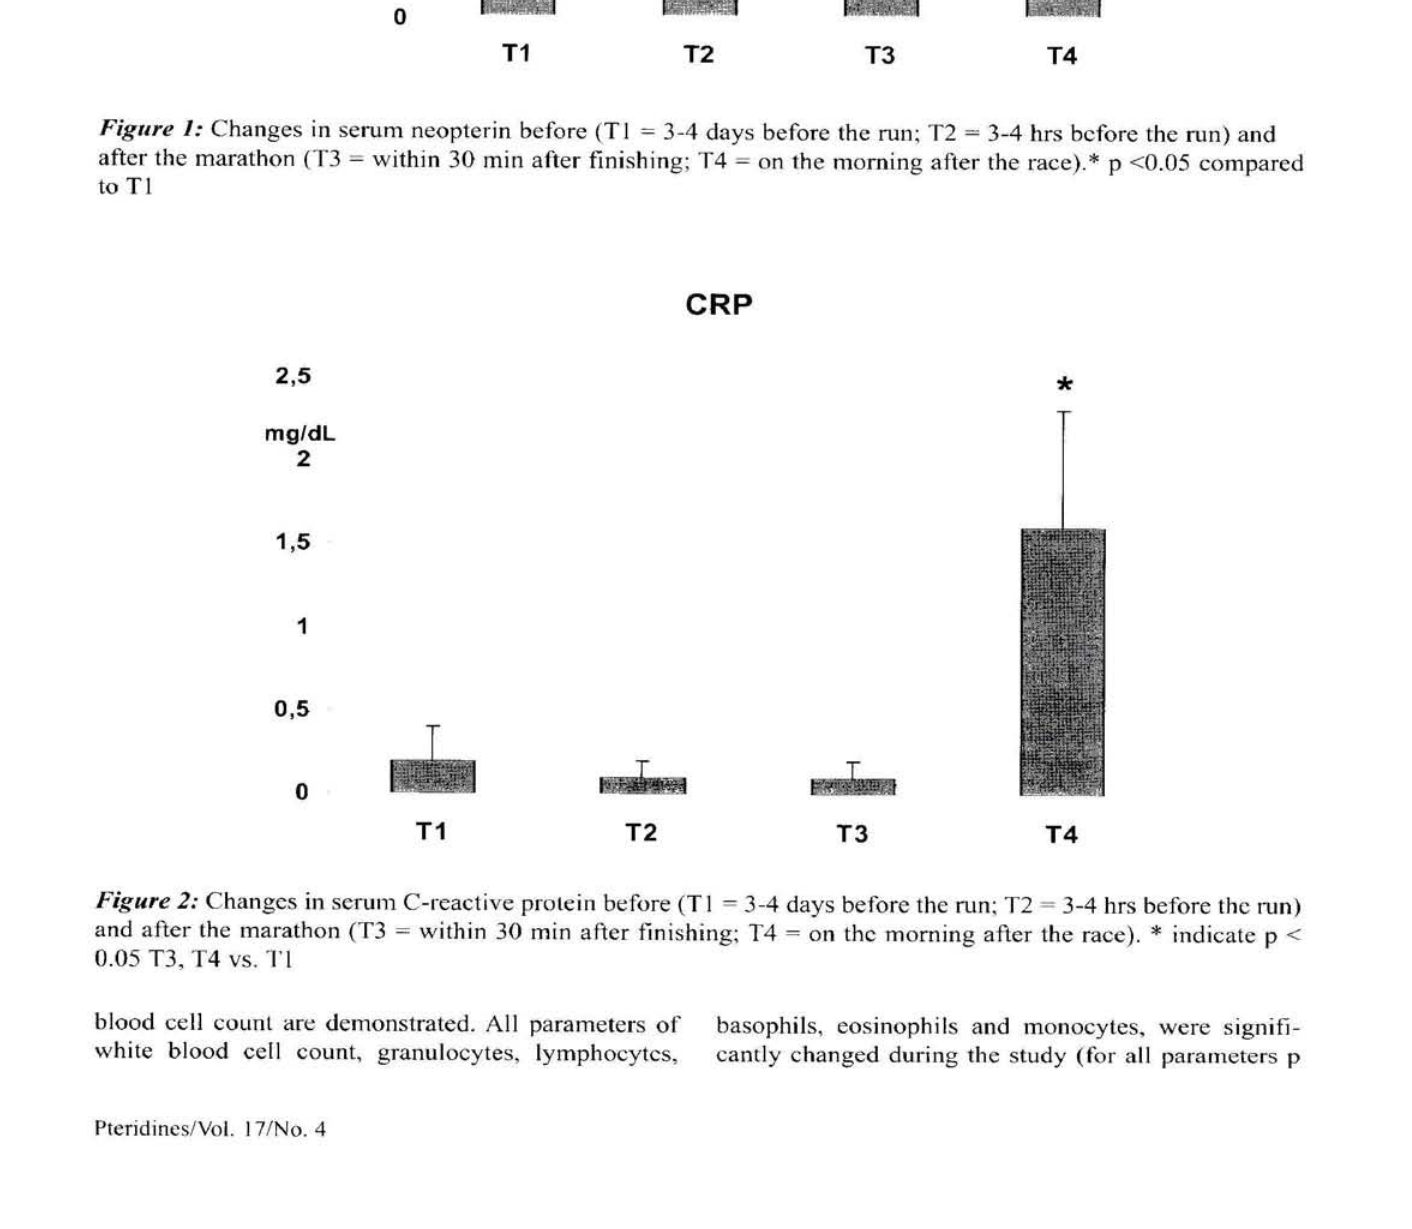
Pteridines/Vol. 17/No.